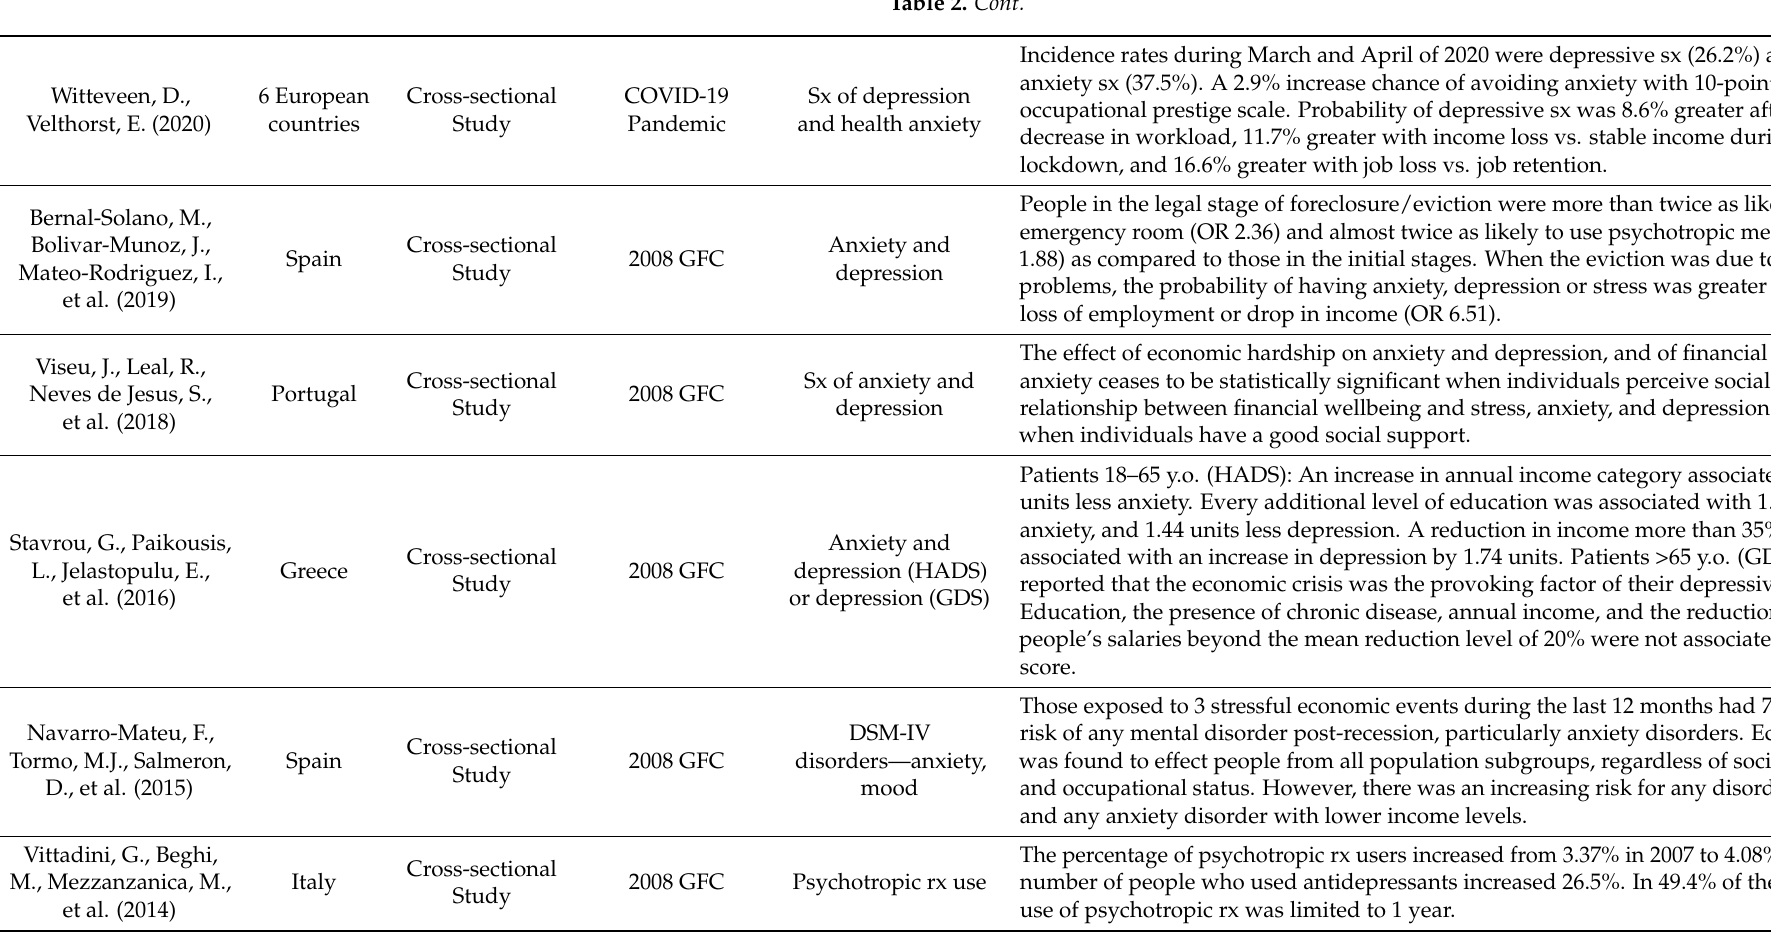
Incidence rates during March and April of 2020 were depressive sx (26.2%) and health anxiety sx (37.5%). A 2.9% increase chance of avoiding anxiety with 10-point increase on occupational prestige scale. Probability of depressive sx was 8.6% greater after sudden and health anxiety decrease in workload, 11.7% greater with income loss vs. stable income during the lockdown, and 16.6% greater with job loss vs. job retention. People in the legal stage of foreclosure/eviction were more than twice as likely to visit an emergency room (OR 2.36) and almost twice as likely to use psychotropic medications (OR 1.88) as compared to those in the initial stages. When the eviction was due to family problems, the probability of having anxiety, depression or stress was greater than if due to loss of employment or drop in income (OR 6.51). The effect of economic hardship on anxiety and depression, and of financial threat on anxiety ceases to be statistically significant when individuals perceive social support. The relationship between financial wellbeing and stress, anxiety, and depression is stronger when individuals have a good social support. Patients 18–65 y.o. (HADS): An increase in annual income category associated with 0.64 units less anxiety. Every additional level of education was associated with 1.18 units less anxiety, and 1.44 units less depression. A reduction in income more than 35% was associated with an increase in depression by 1.74 units. Patients >65 y.o. (GDS): 35.3% reported that the economic crisis was the provoking factor of their depressive sx. Education, the presence of chronic disease, annual income, and the reduction in the people’s salaries beyond the mean reduction level of 20% were not associated with GDS score. Those exposed to 3 stressful economic events during the last 12 months had 7 times greater risk of any mental disorder post-recession, particularly anxiety disorders. Economic crisis was found to effect people from all population subgroups, regardless of social standing and occupational status. However, there was an increasing risk for any disorder, any mood, and any anxiety disorder with lower income levels. The percentage of psychotropic rx users increased from 3.37% in 2007 to 4.08% in 2011. The number of people who used antidepressants increased 26.5%. In 49.4% of the patients, the use of psychotropic rx was limited to 1